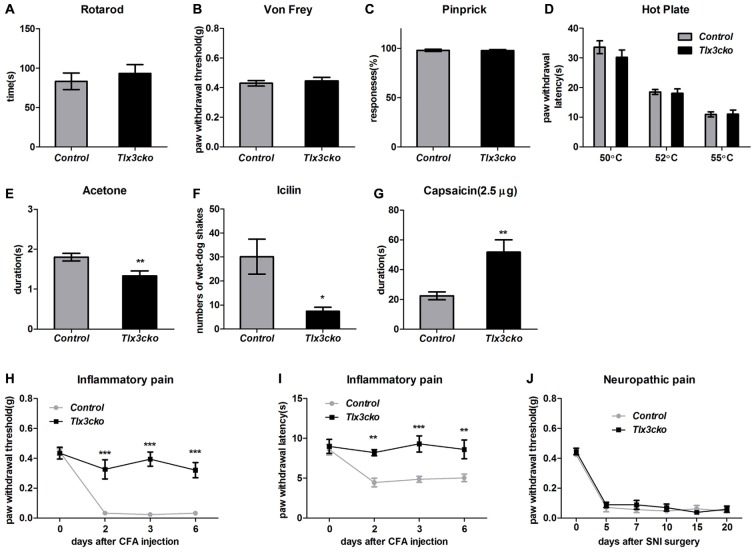
Impaired response to cold, Inflammatory pain and elevated response to capsaicin in Tlx3cko mice. (A) Rotarod test. Tlx3cko mice showed normal sensormotor coordination (fallen time: control, 83.3 ± 10.5 s, n = 7; Tlx3cko, 93.3 ± 11.2 s, n = 7, p = 0.5279). Normal mechanical sensitivity in Tlx3cko mice tested by Von-Frey filaments (control, 0.42 ± 0.2 g, n = 11; Tlx3cko, 0.45 ± 0.2 g, n = 14; p = 0.6073) (B) and pinprick (control, 98% ± 1.2%, n = 5; Tlx3cko, 98% ± 1.0%, n = 7; p = 0.9298) (C). (D) Hotplate assay. Tlx3cko mice showed similar thermal thresholds with control mice. For 50°C, control, 33.6 ± 2.1 s, n = 8; Tlx3cko, 30.2 ± 2.4 s, n = 9; p = 0.3233. For 52°C, control, 18.5 ± 0.8 s, n = 8; Tlx3cko, 18.1 ± 1.5 s, n = 9; p = 0.8244. For 55°C, control, 10.9 ± 0.9 s, n = 8; Tlx3cko, 11.1 ± 1.3 s, n = 9; p = 0.9269. Cold pain was impaired in Tlx3cko mice examined by acetone evaporation assay (control, 1.8 ± 0.1 s, n = 17; Tlx3cko, 1.3 ± 0.1 s, n = 14; p = 0.0048) (E) and Icilin injection (control, 30 ± 7, n = 6; Tlx3cko, 7 ± 2, n = 5; p = 0.0217) (F). (G) Enhanced response to capsaicin in Tlx3cko mice (control, 22.3 ± 2.6 s, n = 9; Tlx3cko, 51.7 ± 8.3 s, n = 10; p = 0.0052). (H,I) Impaired response to inflammatory pain in Tlx3cko mice, (H) mechanical threshold and (I) thermal thresholds (repeated measures two-way ANOVA followed by Bonferroni post test, p < 0.01). (J) Normal response to neuropathic pain in Tlx3cko mice (repeated measures two-way ANOVA followed by Bonferroni post test, p > 0.05). *, **, ***indicate p < 0.05, p < 0.01, p < 0.001, respectively.